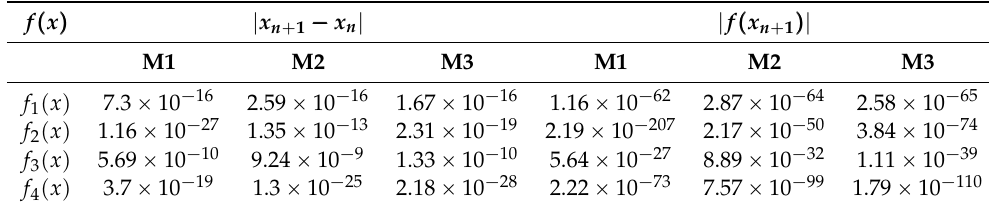
Table 3. Benchmark comparison of fourth-order methods in relation to the absolute error | x n ` 1 ´ x n | and | f p x n ` 1 q|